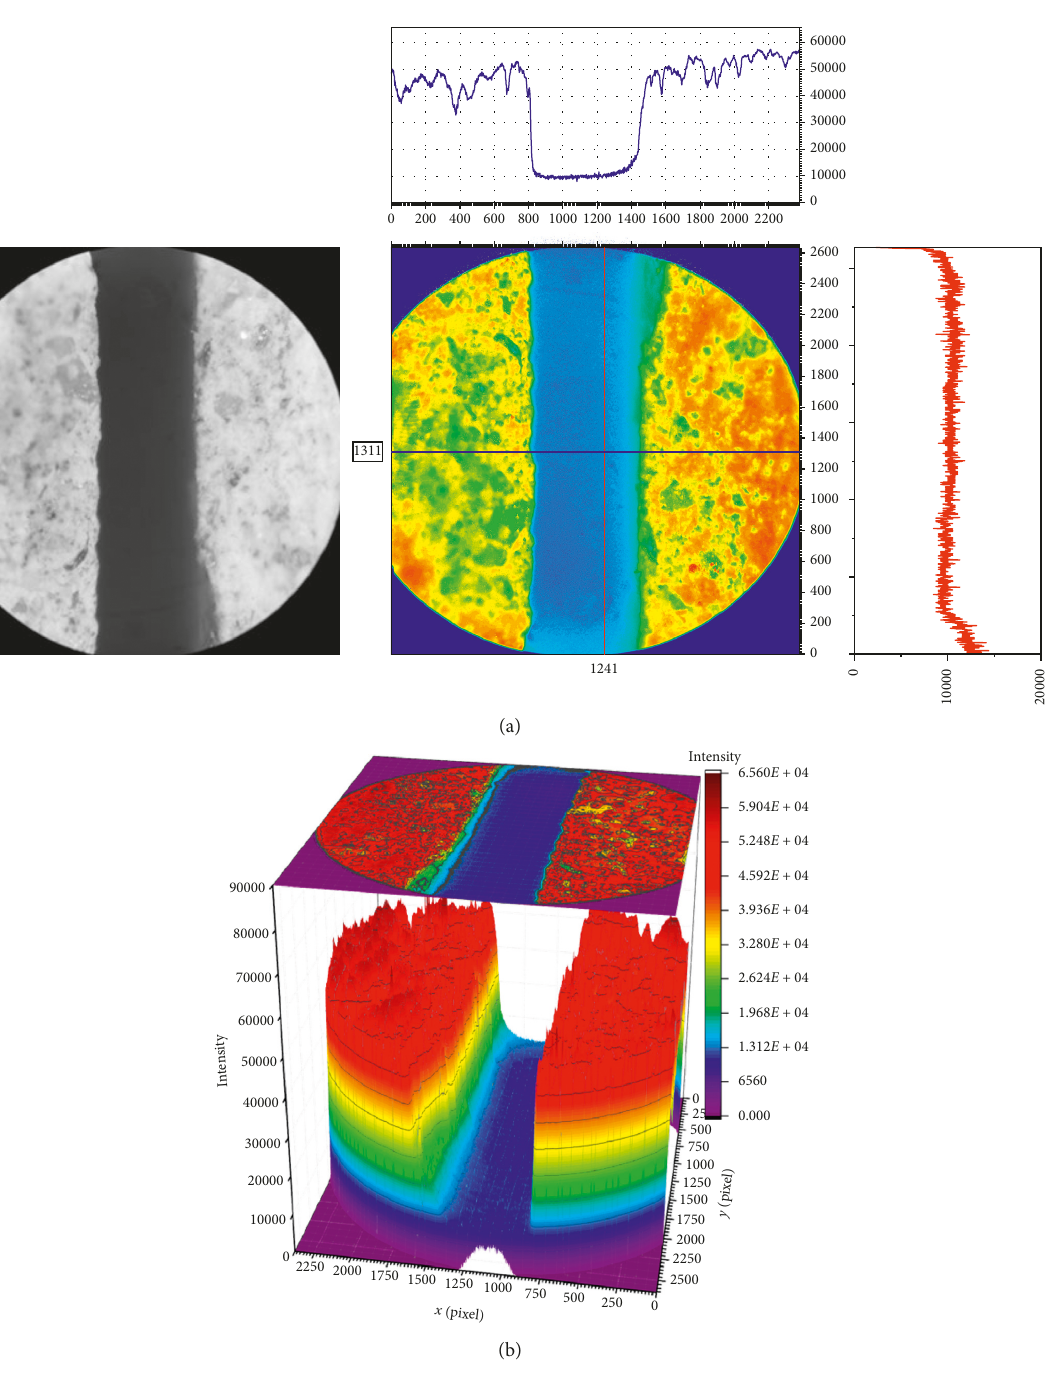
Figure 7: Gray scale crack image and its pixel intensity distribution in both 2D and 3D